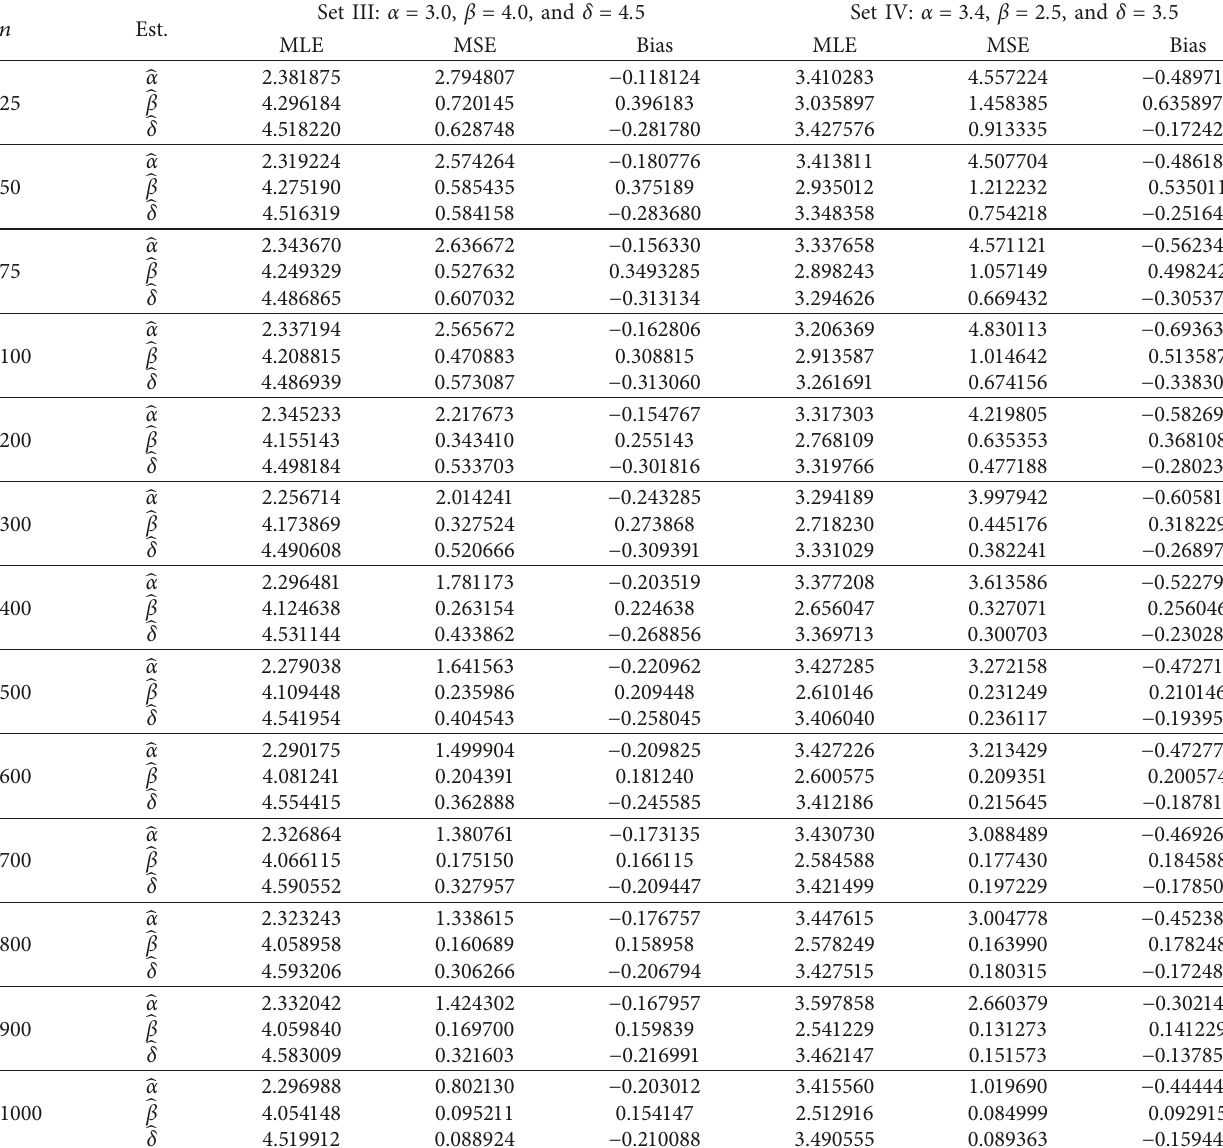
Table 2: The results of conducting a simulation using the NFLog-Wei distribution with sets III and IV. n Est.